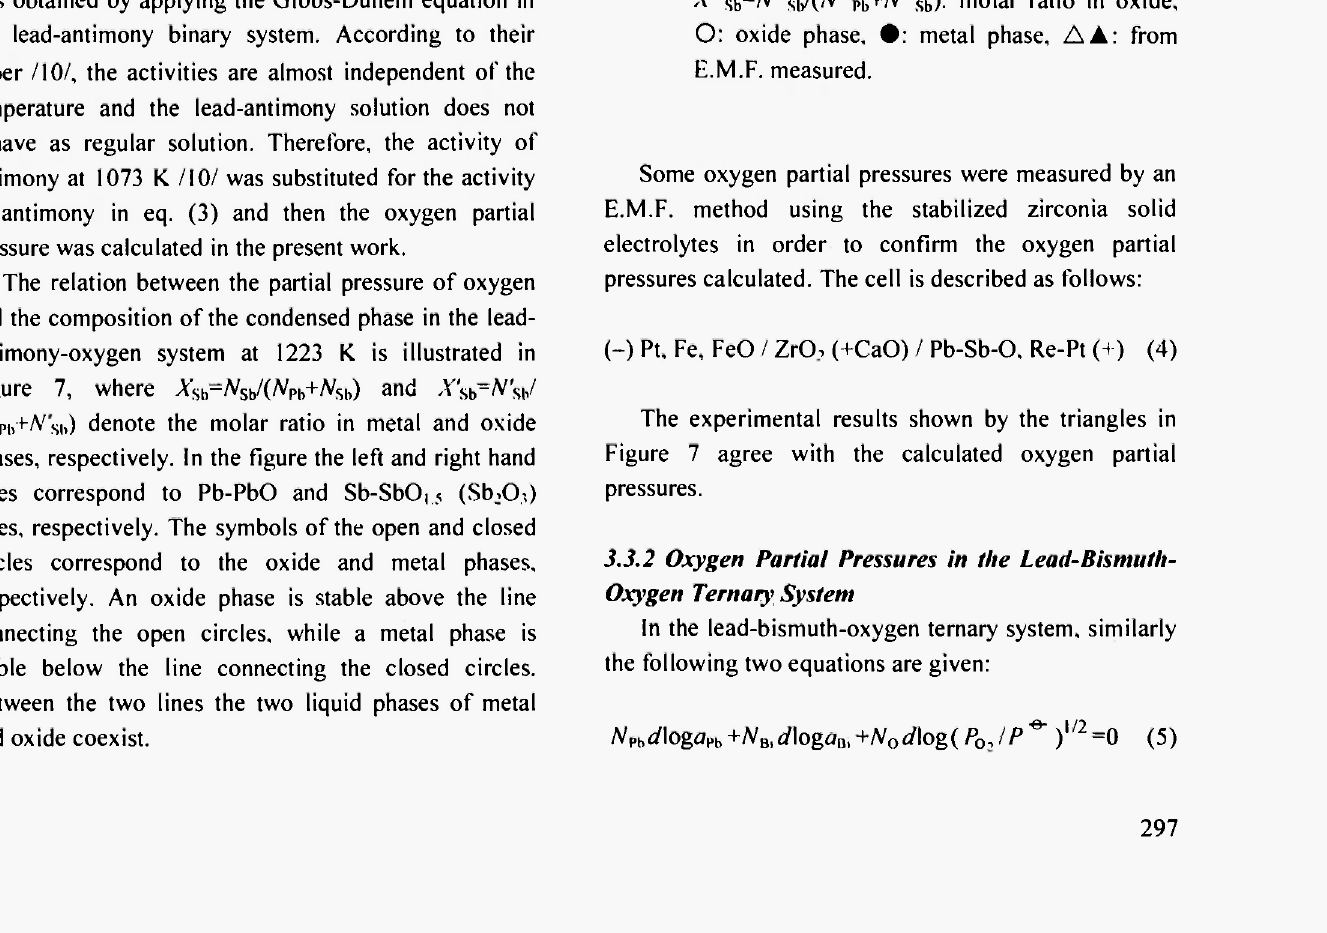
^ Sb Fig. 7: Relation between the partial pressure of oxygen and the composition of condensed phase in the lead-antimony-oxygen system at 1223 K, where X sh =N % iJ(N' Ph +N sh ): molar ratio in